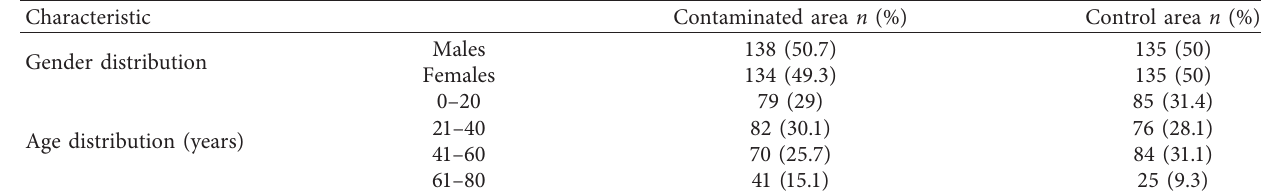
Table 1: Demographic characteristics of the study population.